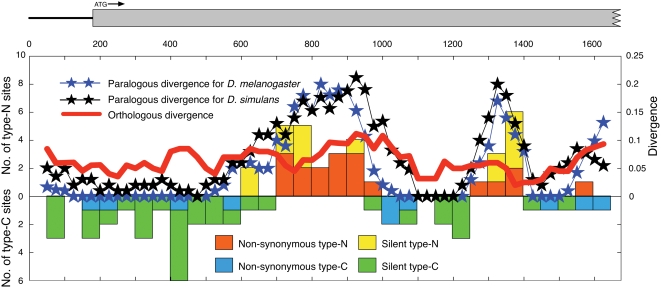
Distributions of divergences and type-C and type-N sites in Pre28, including the CG18281-CG17637 gene pairs in D. melanogaster.The orthologous divergence (d
0) is the average of dXm
−Xs and dYm
−Ys.